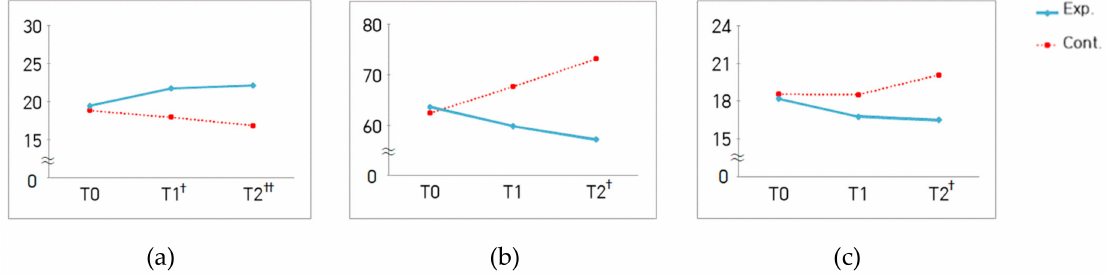
Figure 1. Changes to the measures of positive emotion ( a ), fatigue ( b ), and physiological stress ( c ) in both groups. T0 = baseline assessment; T1 = 2nd week of the program; T2 = 4th week of the program; † p < 0.05, †† p < 0.01 indicates group differences by time